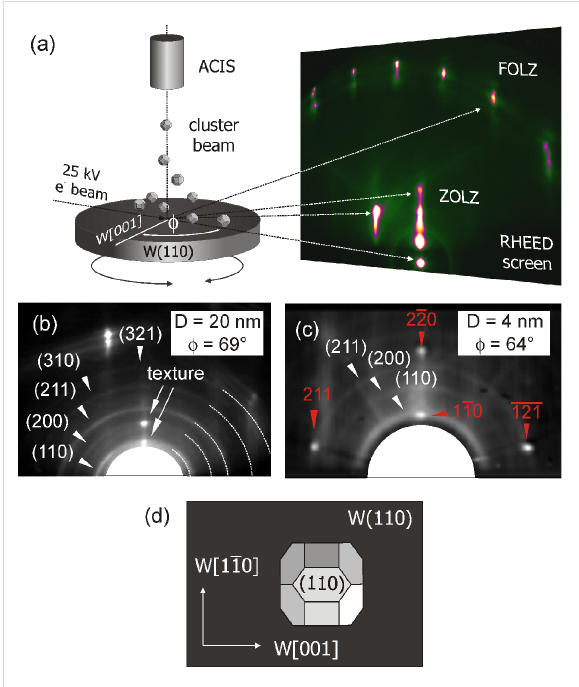
Figure 3: (a) Schematics of the in situ RHEED setup [58] (b) and (c): RHEED diffraction patterns from (b) larger (20 nm) and small (c) parti- cles (4 nm). (d) Schematic drawing of uniformly oriented Fe particles on